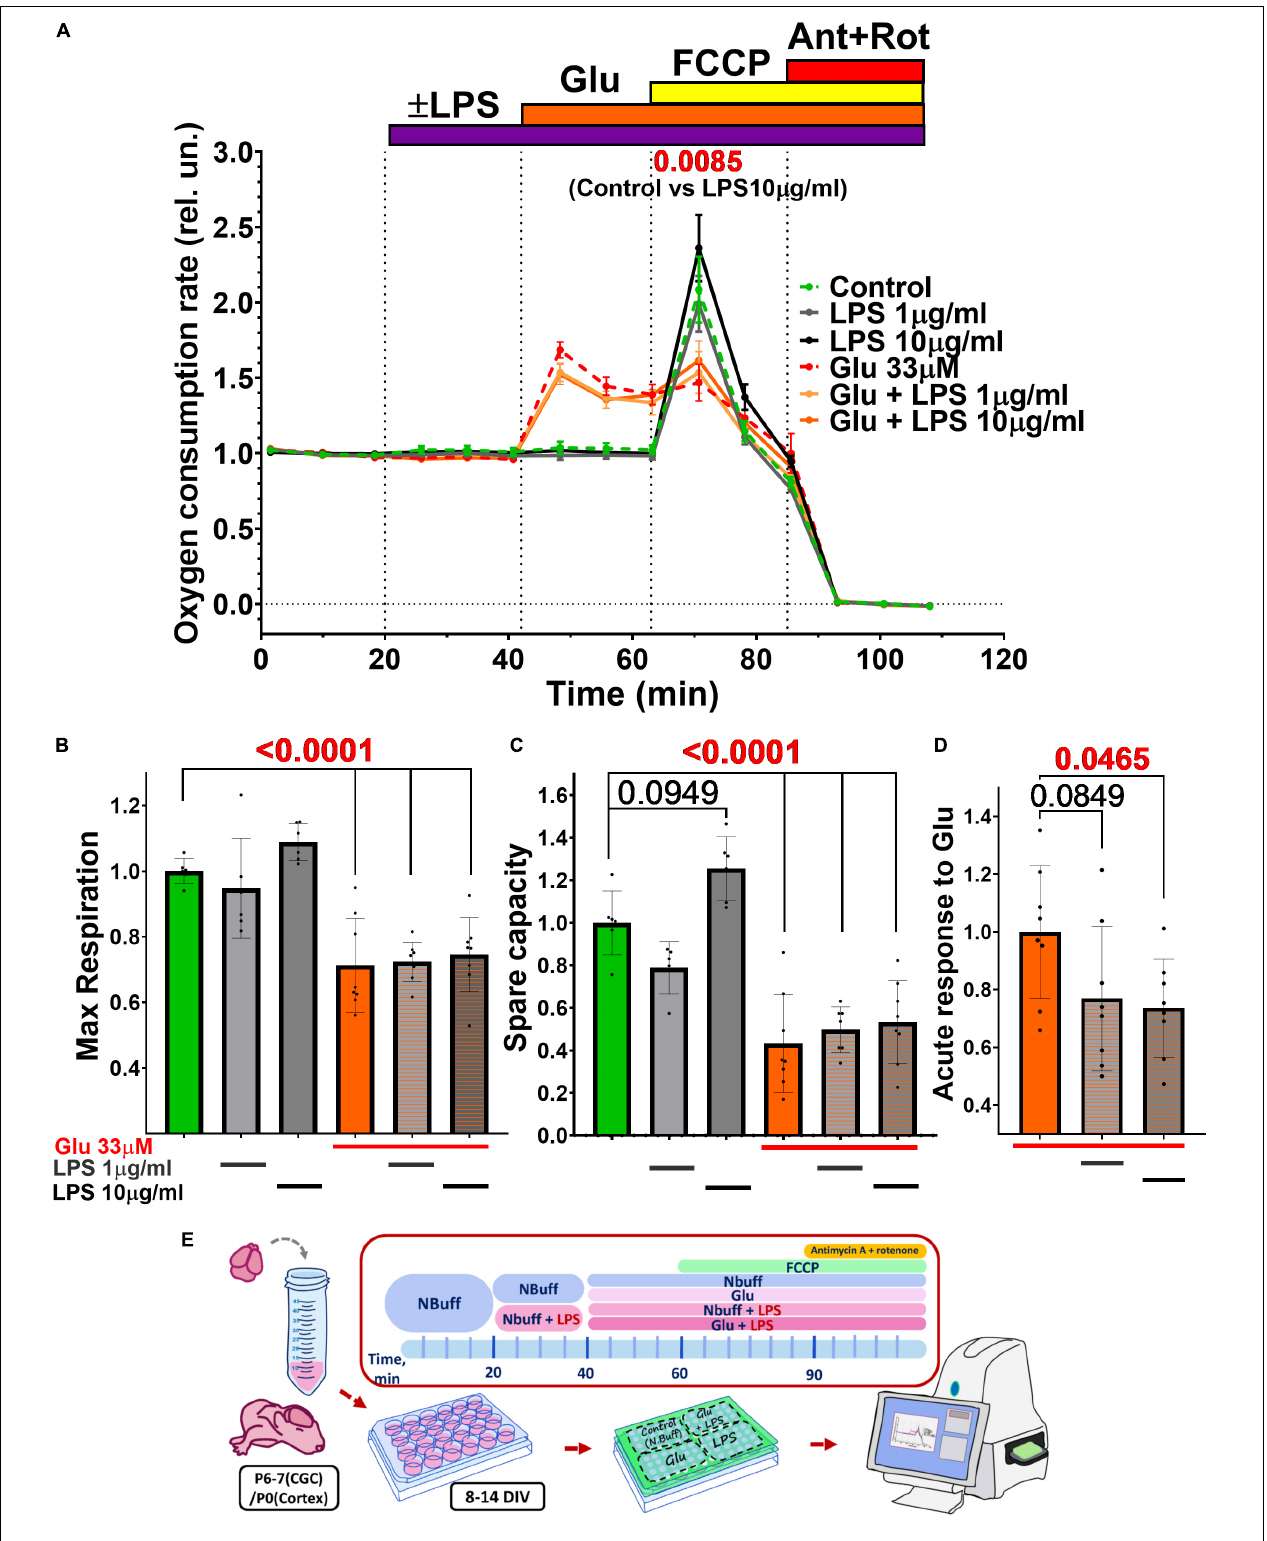
FIGURE 6 | Effect of glutamate (Glu) and lipopolysaccharide (LPS) on the oxygen consumption rate (OCR) by cultured rat cerebral neurons. (A) The oxygen consumption rate (OCR) normalized to the culture density in each well of the plate, and then normalized to the basal OCR values (100–200 pmol O2/min)